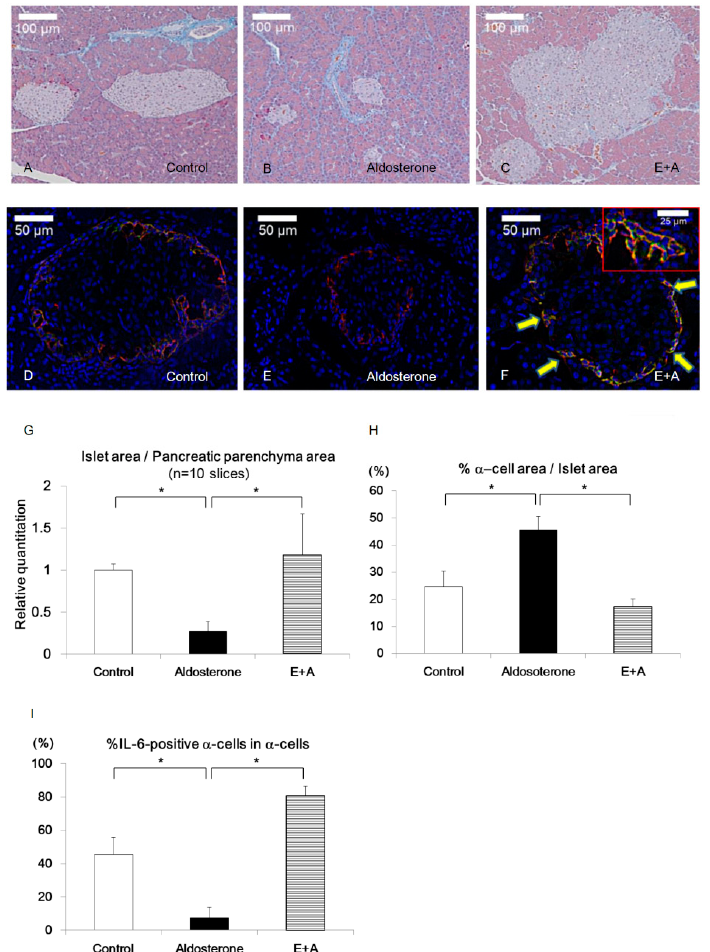
Figure 2. Histological analysis of pancreatic islets in PA model rodents. ( A – C ) Masson’s trichrome staining of the islets of each treatment group. ( D – F ) Double staining of glucagon (red) and IL-6 (green) of the islets of each treatment group. Arrows in F indicate IL-6-positive staining in α -cells. ( G ) Islet/pancreatic parenchyma area ratio of each group ( n = 10 slices). ( H ) Percentages of α -cells area in islet area. ( I ) Percentages of IL-6-positive α -cells in α -cells. Scale bars in (A–C) = 100 μ m and scale bars in (D–F) = 50 μ m. * p < 0.05. Data are shown as mean ± SE.